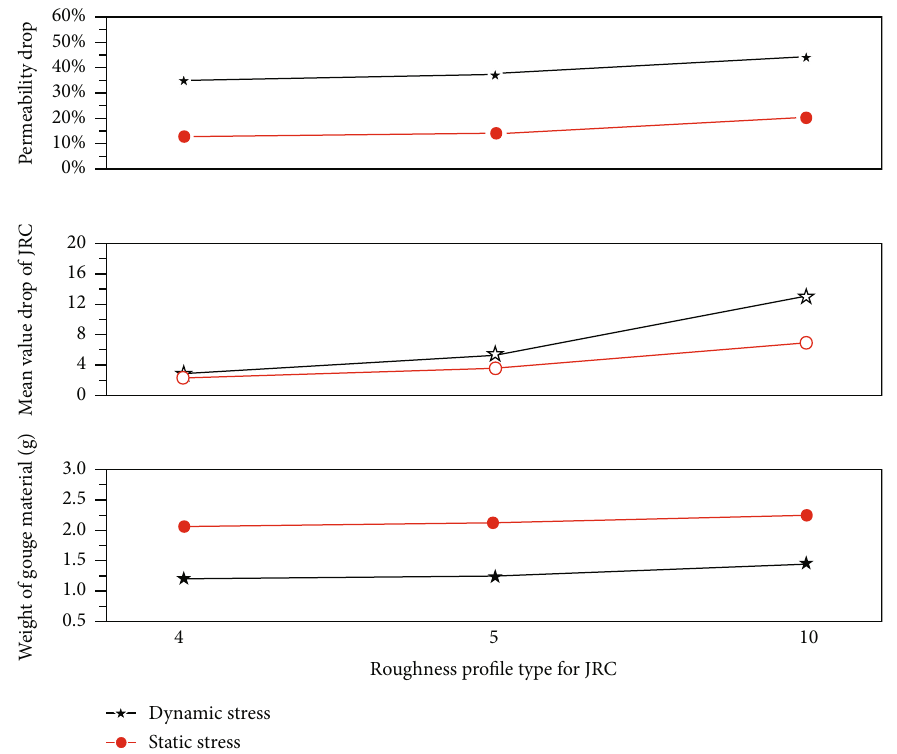
Figure 16: Comparing permeability drop, mean value drop of JRC, and weight of gouge material after testing under dynamic stress and static